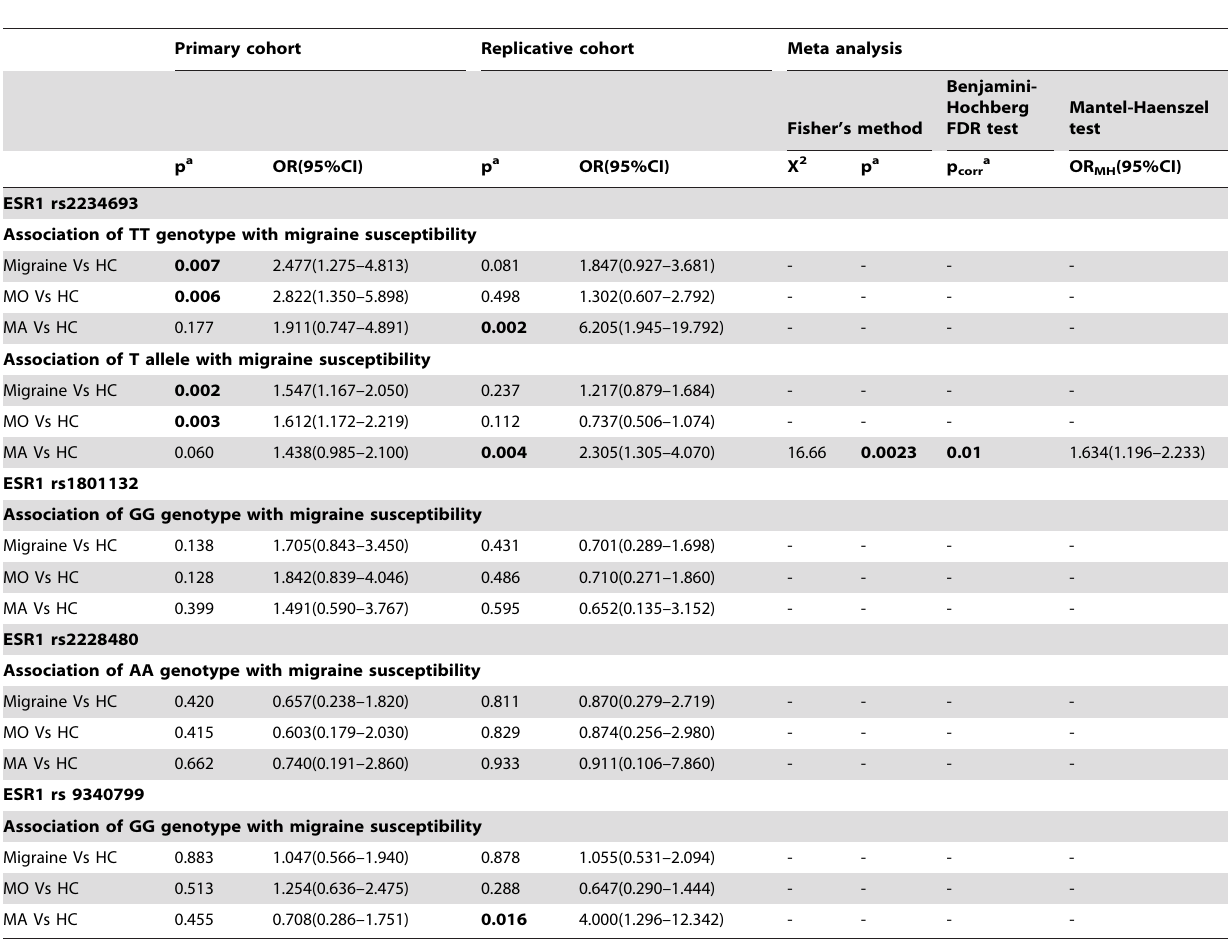
Table 4. Association study of ESR1